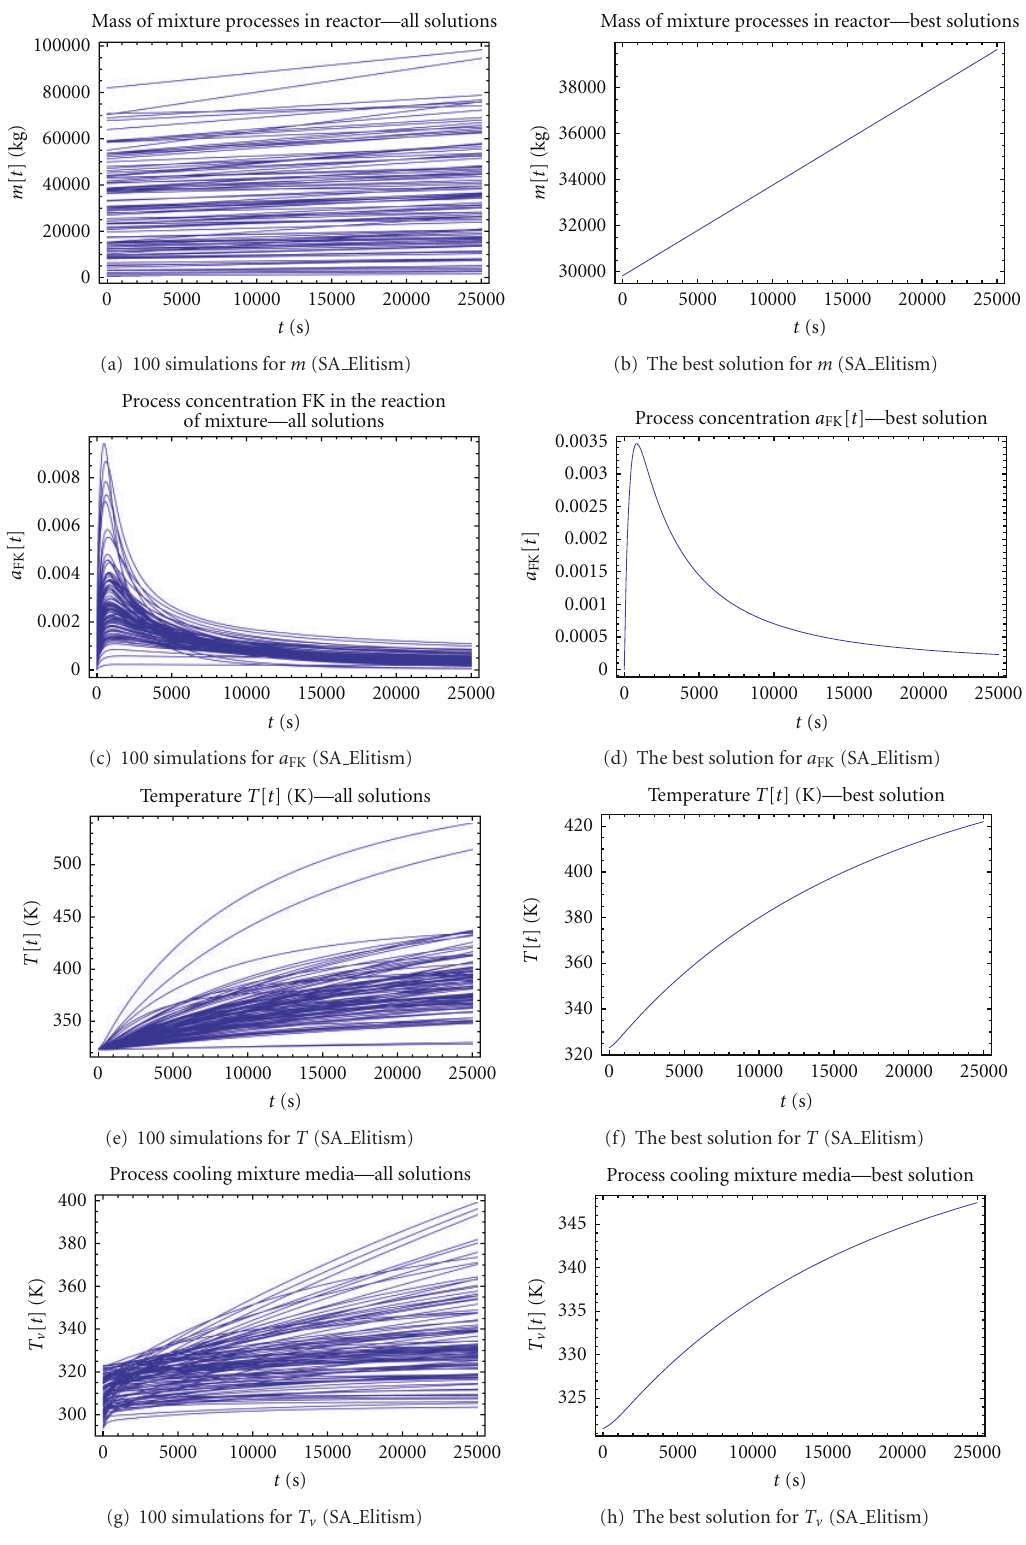
Figure 10: Processes parameters for 100 simulations of SA—version SA